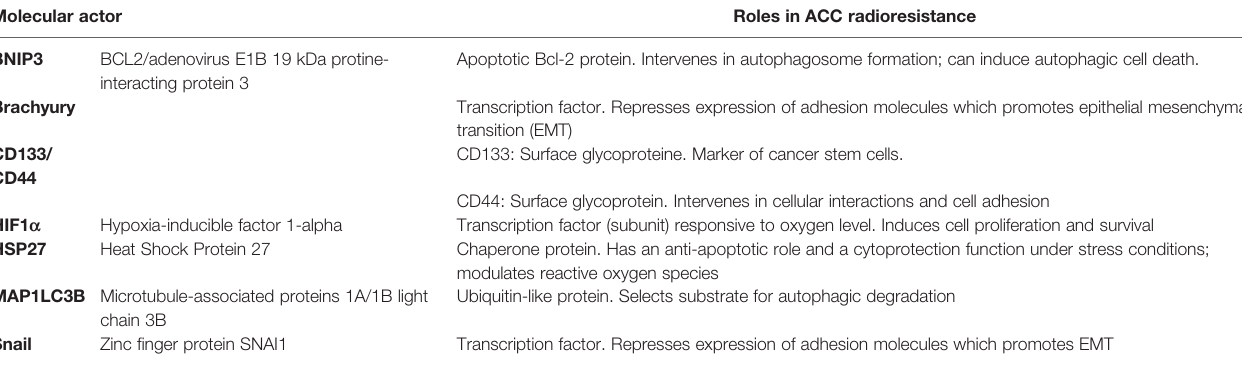
Transcription factor. Represses expression of adhesion molecules which promotes